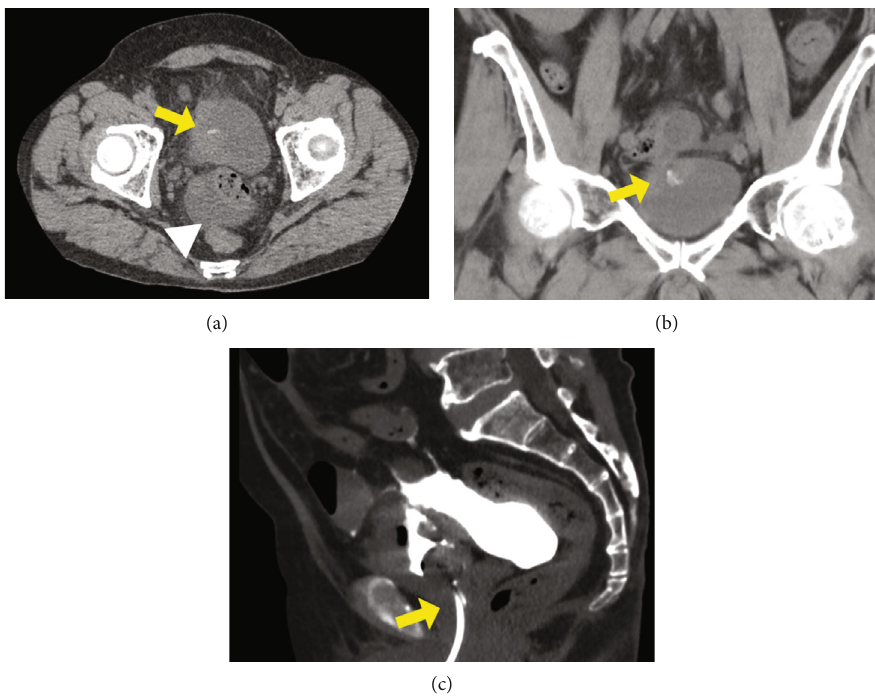
Figure 1: (a) An axial plain abdominal computed tomography (CT) scan showed bladder wall thickening with calci fi cation (arrow) and ascites in the rectovesical pouch (white arrowhead). (b) A coronal plain abdominal CT scan showed bladder wall thickening adjacent to the ileum (arrow). (c) A sagittal CT scan after intravesical injection of contrast medium via a urethral catheter (arrow) showed leakage of contrast medium into the abdominal cavity.